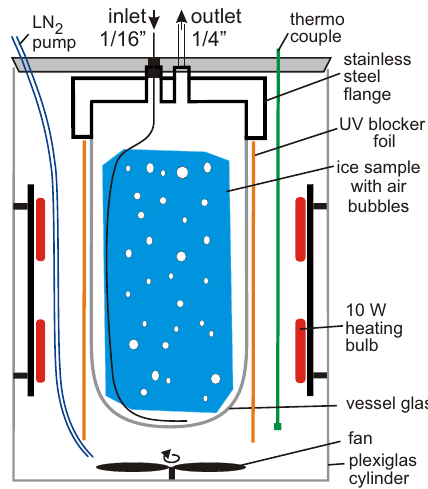
Figure 2. Custom-built vessel holder with sample glass vessel to automatically melt ice samples using infrared light (heating bulbs + UV light blocker foil) or to keep the ice at around − 5 ◦ C using LN 2 during pumping and procedure blank